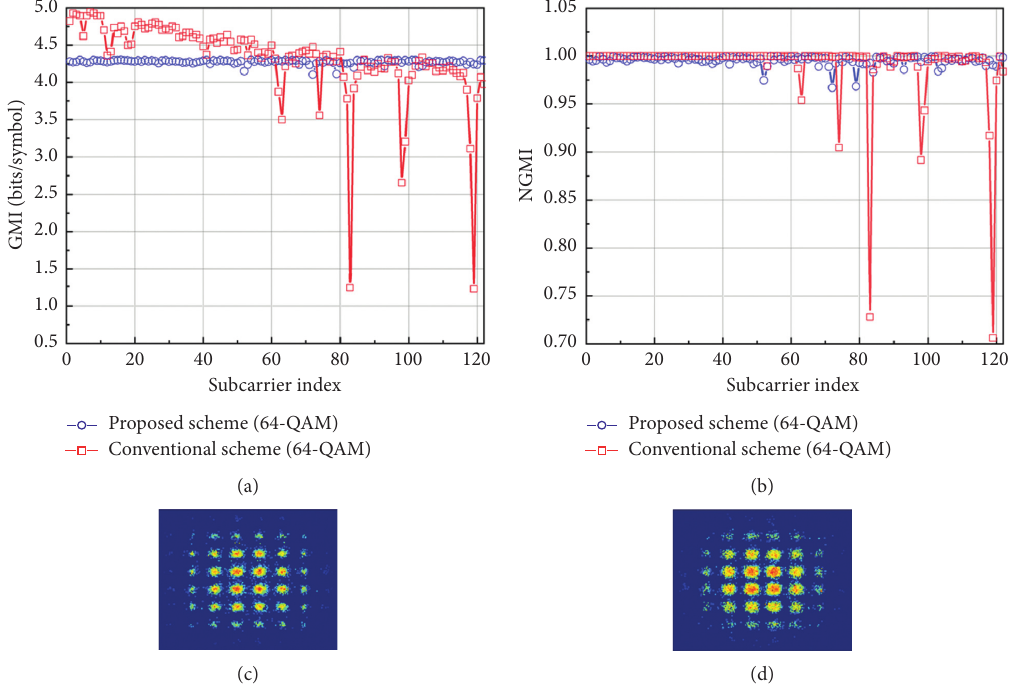
Figure 4: Experimental verification when modulation order is 64-QAM: (a) GMI as a function of subcarrier index, (b) NGMI as a function of subcarrier index, (c) corresponding constellation density of the scheme without precoding, and (d) corresponding constellation density of the proposed scheme with OCT